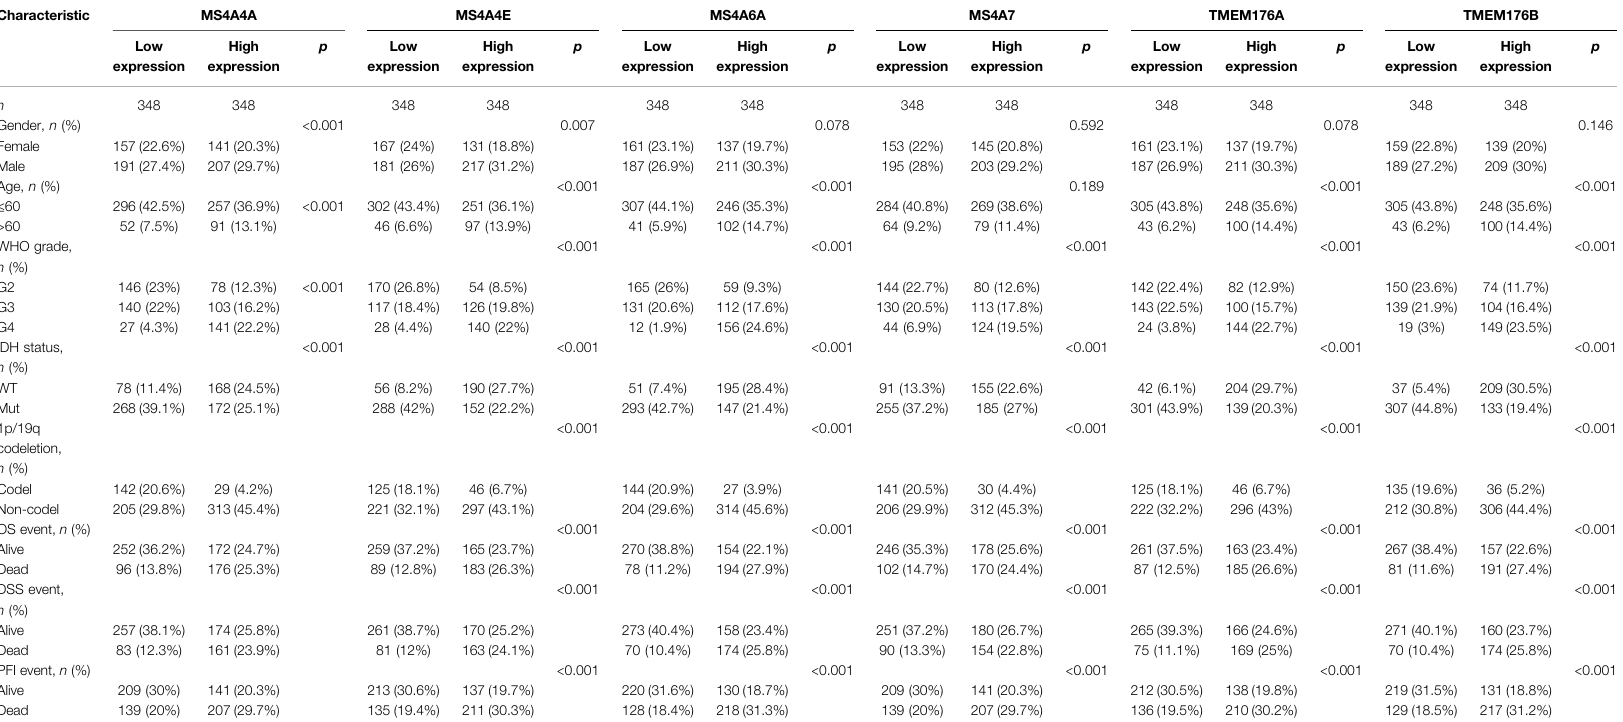
TABLE 1 | Baseline data from TCGA-GBM and